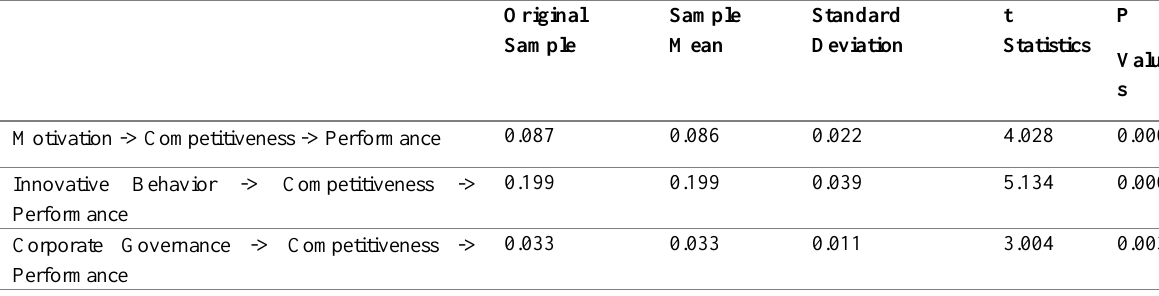
Table 3: Indirect Effects Between